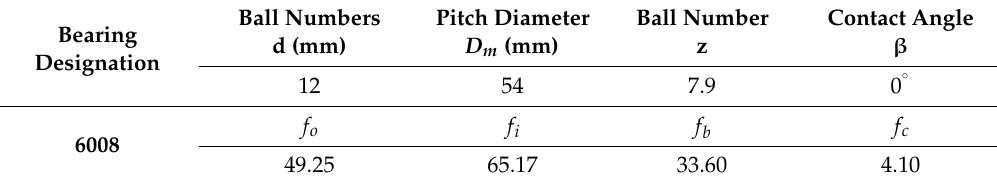
Table 2. Specification and characteristic frequency of the planetary gear bearing.